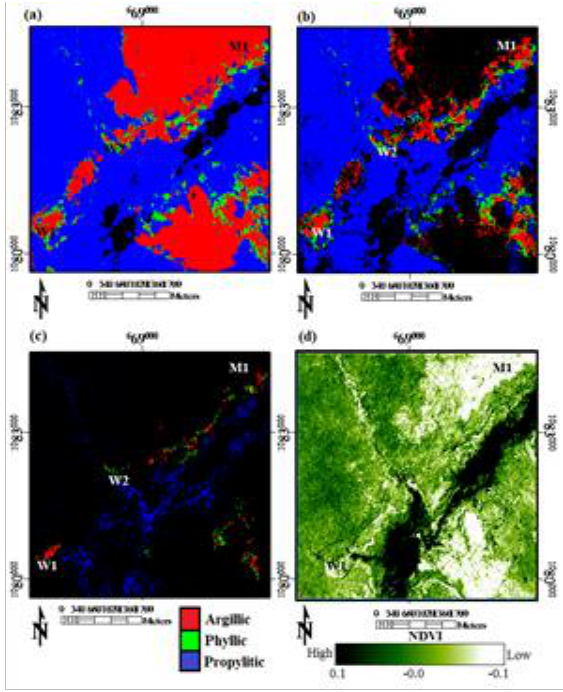
Figure 2. Results of SAM at Wikki ROI using image spectra